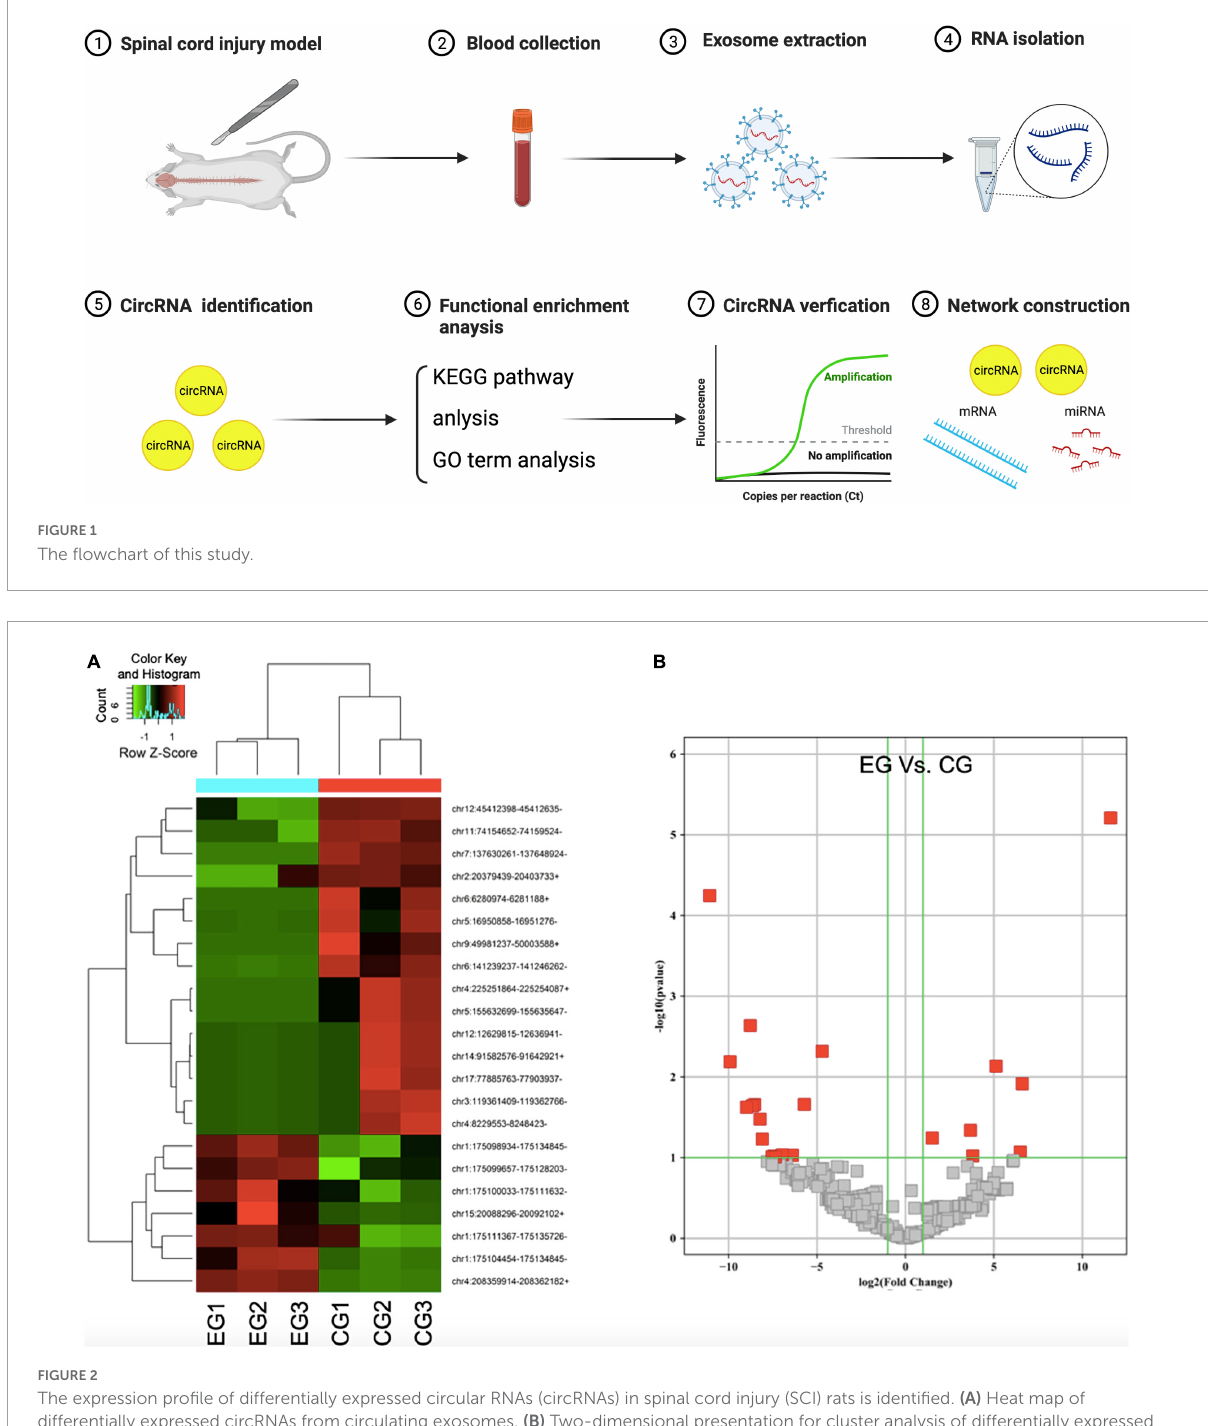
selected through RNA sequencing ( Figure 2 ). Later on, the potential roles of these circulating circRNAs in SCI rats were predicted via KEGG and GO analyses ( Figures 3 , 4